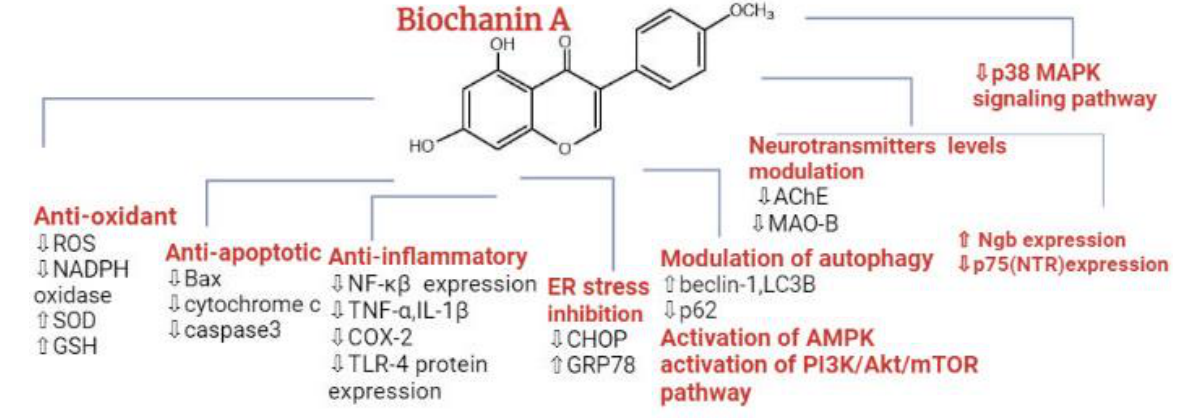
Fig.1: Molecular mechanisms of the neuroprotective effect of